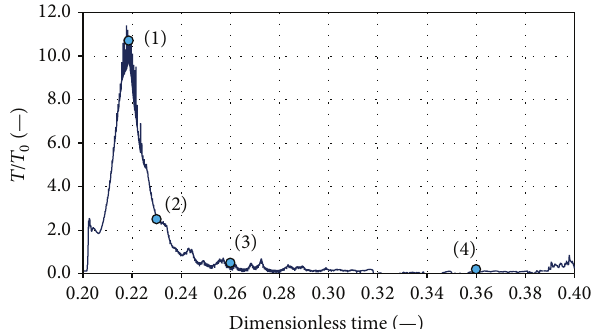
Figure 17: Second impact data related to run 3D-2: dimensionless resistant torque.